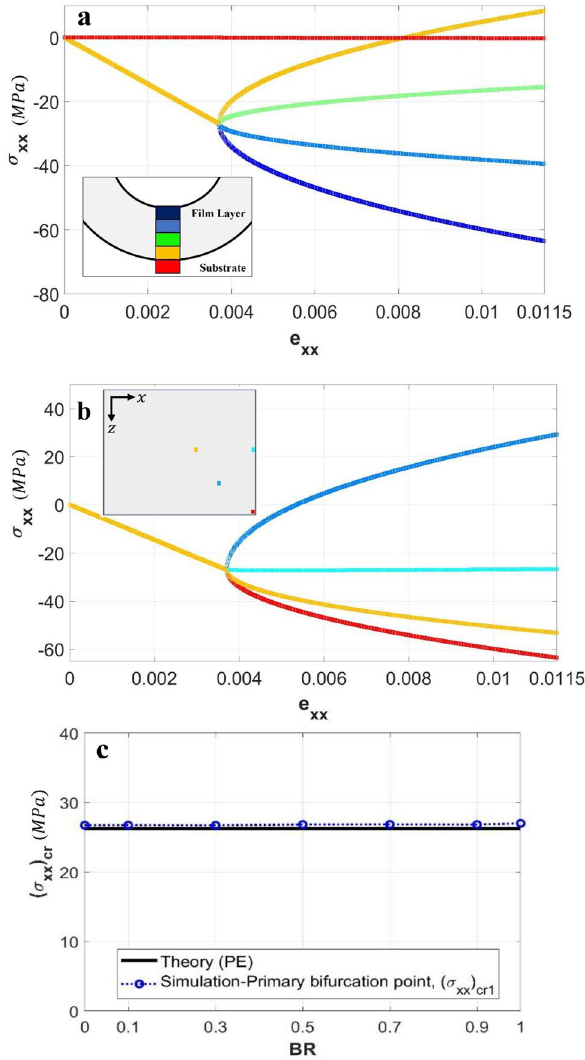
Figure 3. ( a, b ) Evolution of stress σ xx as a function of applied strain e xx , ( a ) through the film thickness and into the top element of the substrate at a chosen location, and ( b ) at various locations of the film’s top surface. ( c ) Variation of critical stress, (σ xx ) cr , with the biaxiality ratio, BR. The theoretical solution is also included for